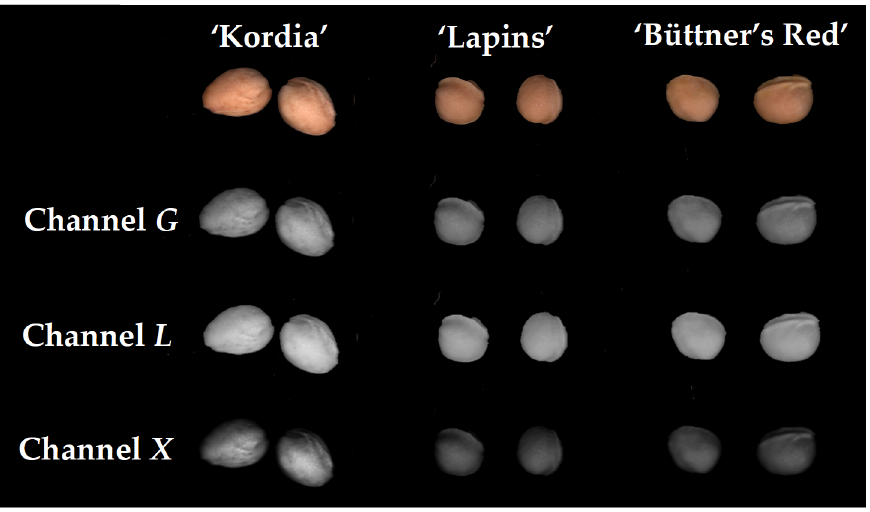
Figure 2. Images of sweet cherry pits from different color channels.